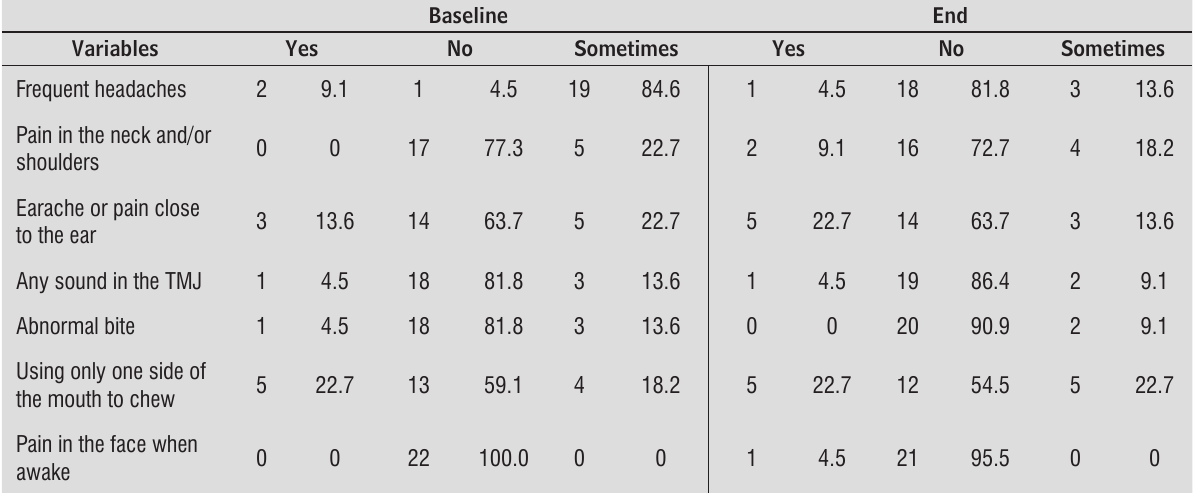
Table 2 - Analysis of the questionnaire to assess the TMD at baseline and at the end of treatment